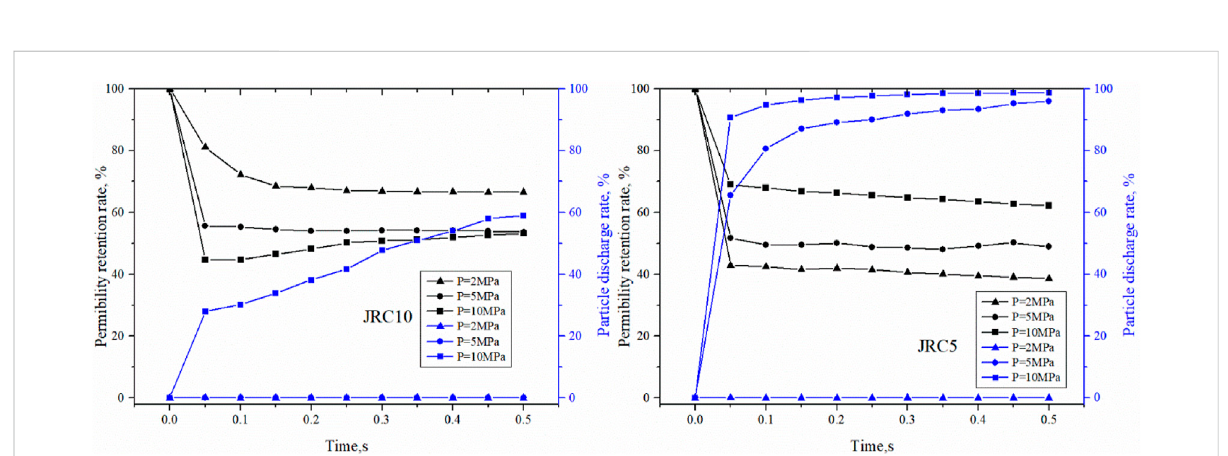
FIGURE 9 Variations of permeability retention rate and particle discharge rate of fractures with different roughnesses at different positive pressure differences.